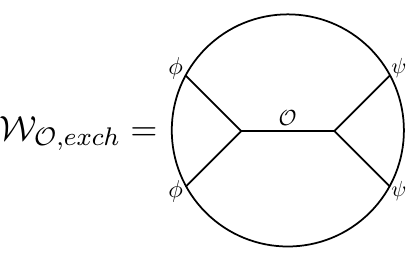
Figure 4 . Exchange Witten diagram where we label the bulk (cid:12)eld by its dual CFT